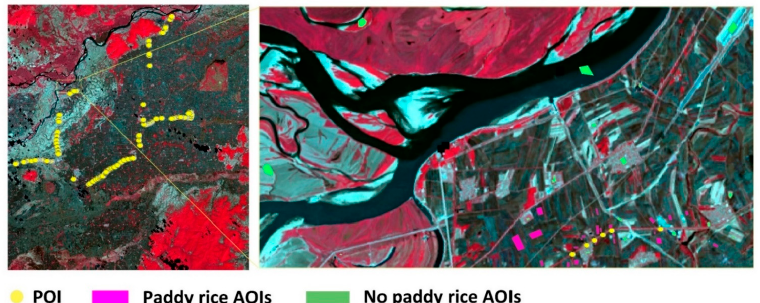
Figure 5. Spatial distribution of field photos in the study area is shown in the left panel and part of the validation area of interest (AOIs) in the right